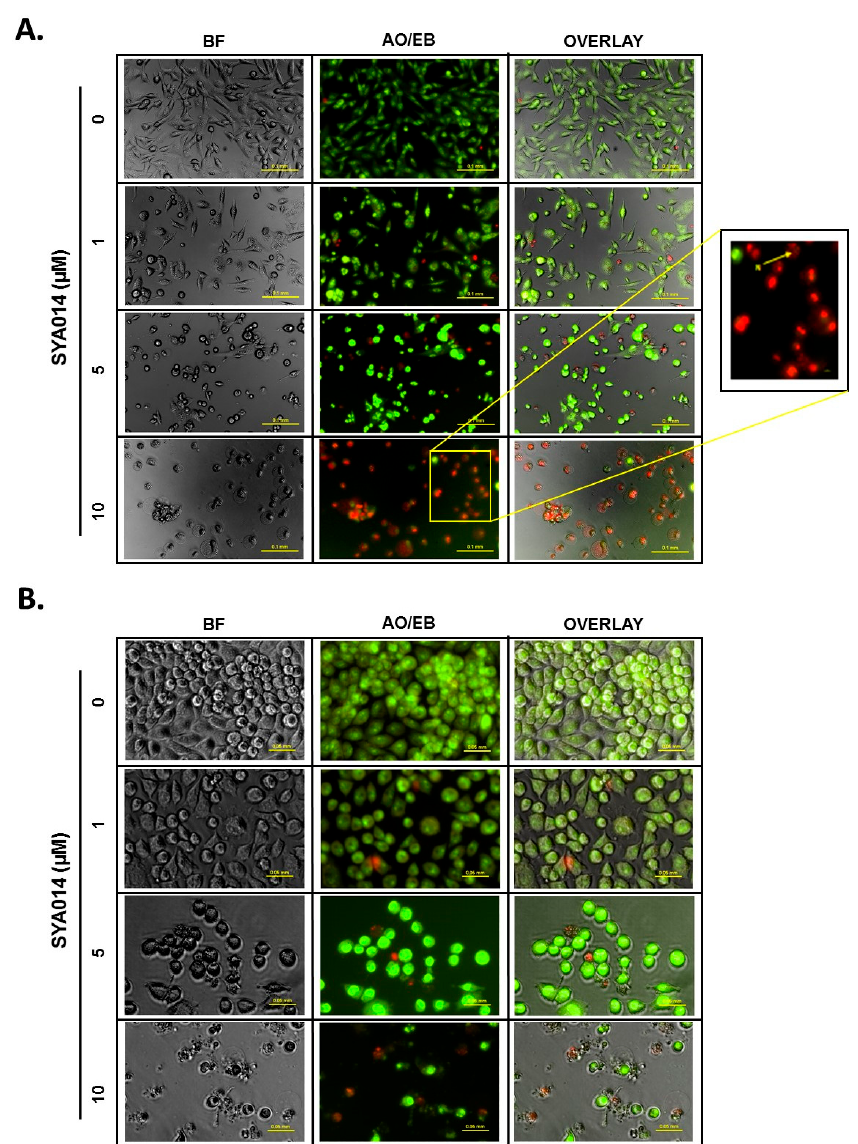
Figure 5. SYA014 induces apoptosis in TNBC cell lines. MDA-MB-231 cells ( A ), and MDA-MB- 468 cells ( B ), were treated with SYA014 at different concentrations for 48 h followed by acridine orange/ethidium bromide (AO/EB) dye staining and fluorescence microscopy analysis. Yellow arrow in the magnified image indicate formation of apoptotic bodies. Scale bar = 50 µ m. BF: